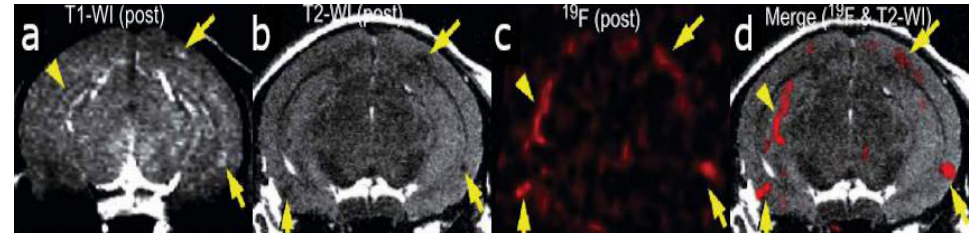
Figure 1. In vivo detection of amyloid plaques (indicated by arrowheads and arrows) in the brain of a Tg2576 mouse after injection with (E,E)-1-fluoro-2,5-bis(3-hydroxycarbonyl-4-hydroxy)styryl-benzene (FSB) [14]. ( a ) T1-weighted 1H imaging of the mouse brain. ( b ) T2-weighted image of the same slice indicating the position of the amyloid-beta plaques. ( c ) 19F MRI image of the mouse brain after FSB injection. ( d ) 19F-FSB image overlaid on top of the high-resolution T2-weighted 1H image. Images are reprinted with permission from the publisher [14].